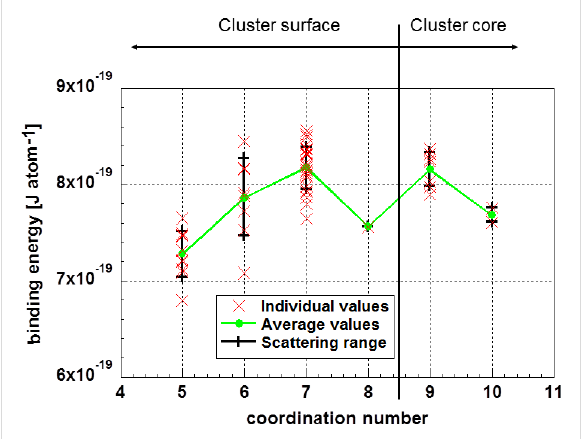
Figure 6: Energy necessary to remove one atom from an Au 55 cluster, which is equivalent to the enthalpy of sublimation. Coordination numbers of eight or less are found at the surface; higher coordination numbers are in the cluster core. The data correspond to the glassy Au 55 cluster (initially crystalline structure annealed at 900 K and subsequently fully relaxed at 0 K).